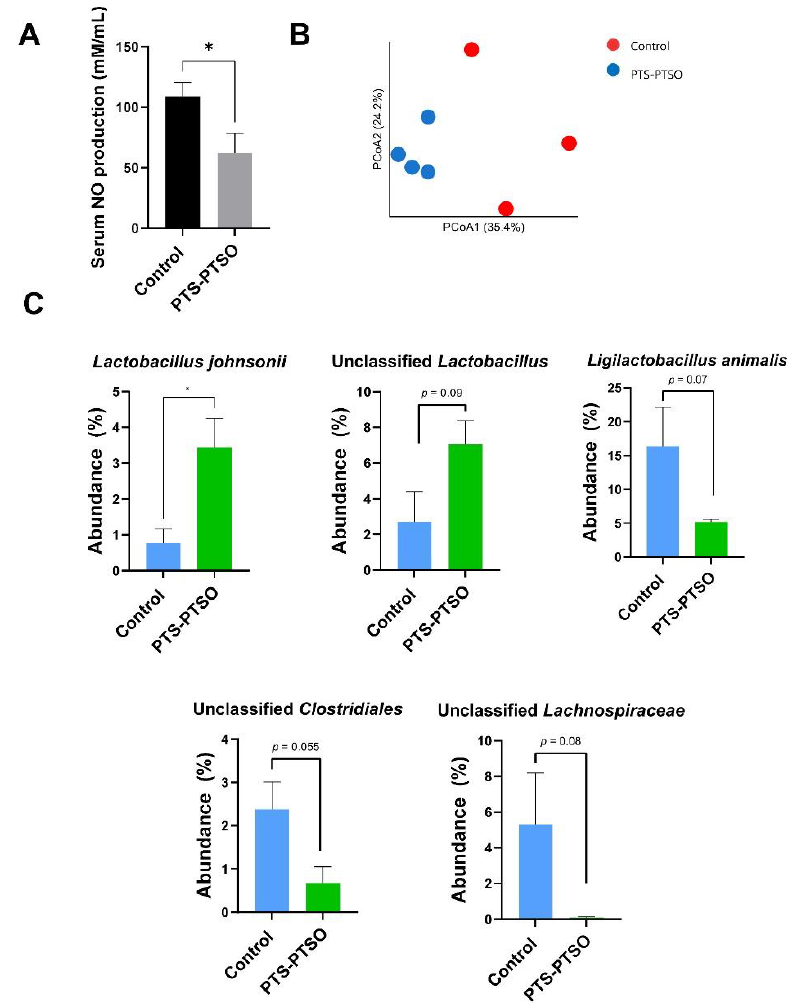
Figure 4. PTS-PTSO modulates serum nitric oxide (NO) levels and faecal microbiota composition. ( A ) Serum nitric oxide level in mice fed with water or 1 mg/kg PTS-PTSO after a 2-week treatment period. ( B ) Principal component analysis based on Bray–Curtis differences in feacal microbiota. ( C ) Relative abundance of bacteria taxa found to differ between PTSO-PTS-treated and control groups. * p < 0.05. Data bars represent mean ± SEM. n = 3–4 per group.